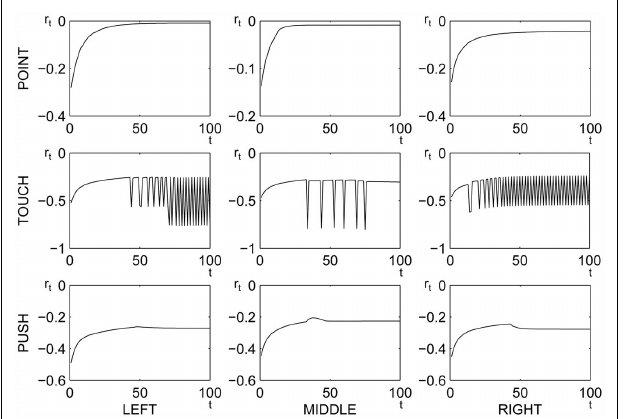
FIGURE 11 |The joint angles and reward values during the execution of the “point-left” action from different starting positions, as a function of discrete time steps (iterations).